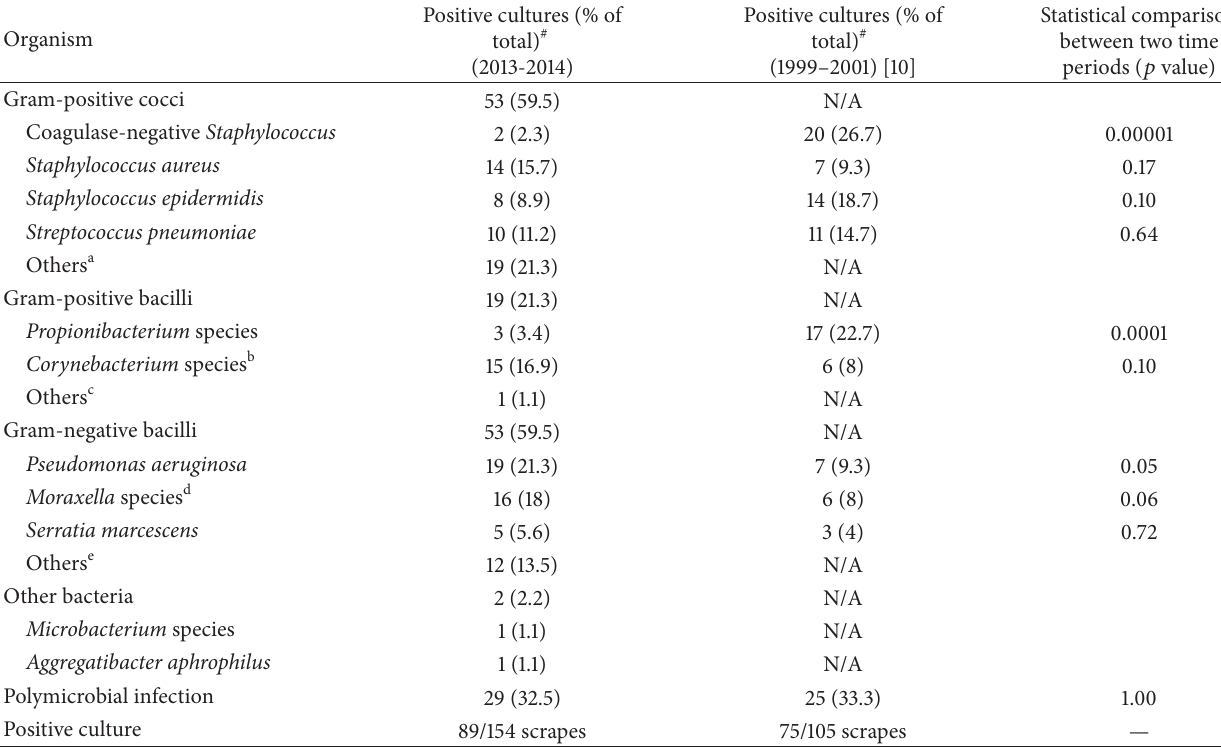
Table 1: Prevalence of bacteria isolated in corneal scrape from severe cases of keratitis in Auckland Hospital in New Zealand (2013-2014) compared with results at the same site in